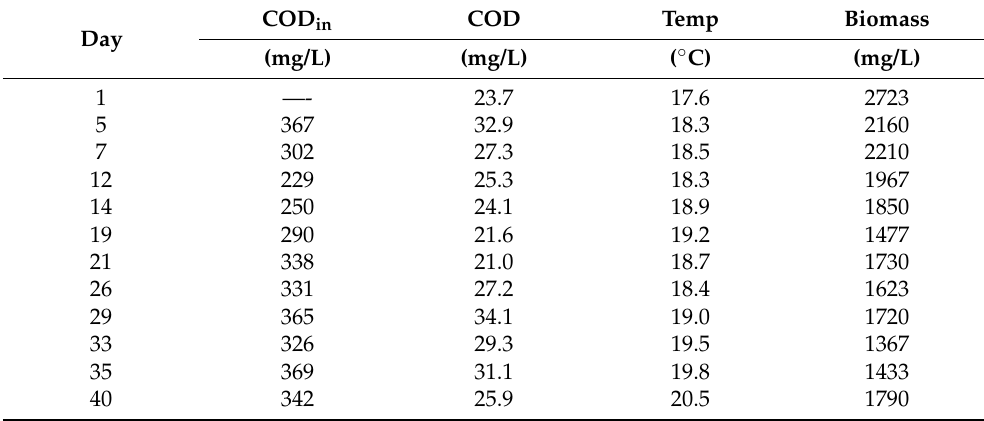
Table 3. Experimental values for biological treatment measured in the WWTP between May 2020 and April 2021 (343 days). Data were supplied by the staff of the